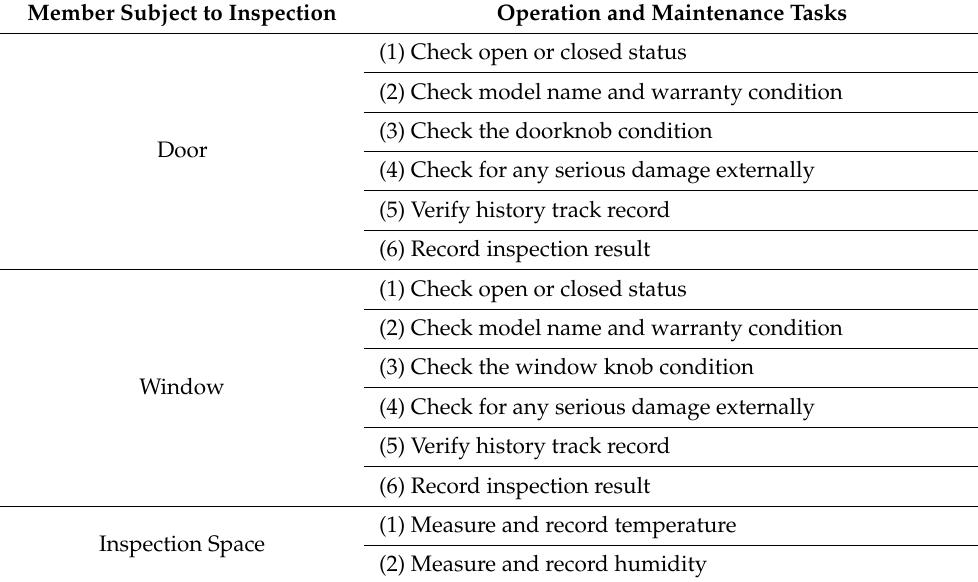
Table 2. Maintenance tasks for